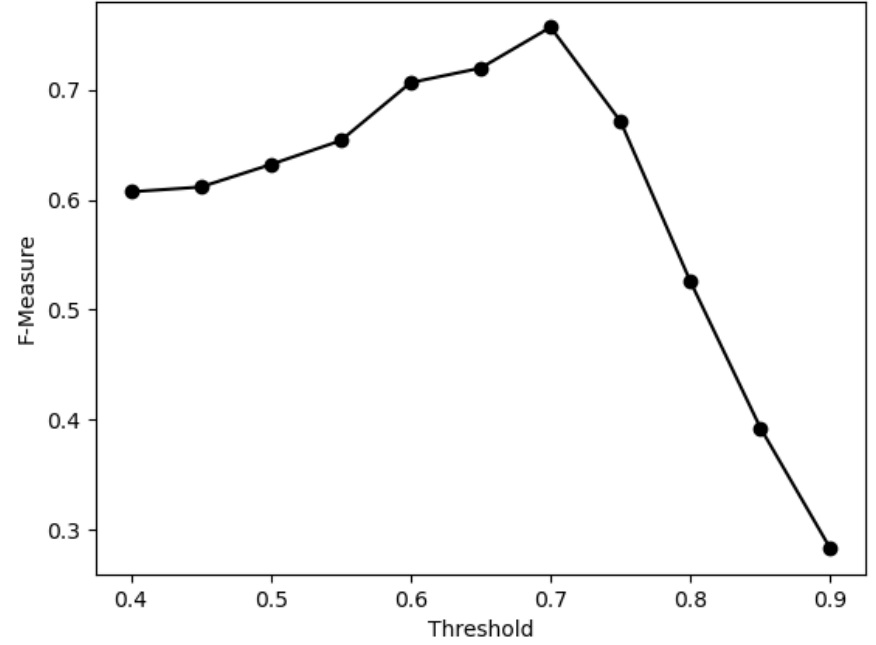
Figure 4. Results for the thresholds selected and corresponding F-Measure Table 4 indicates the results for the truth set creation with the semi-automated ap-